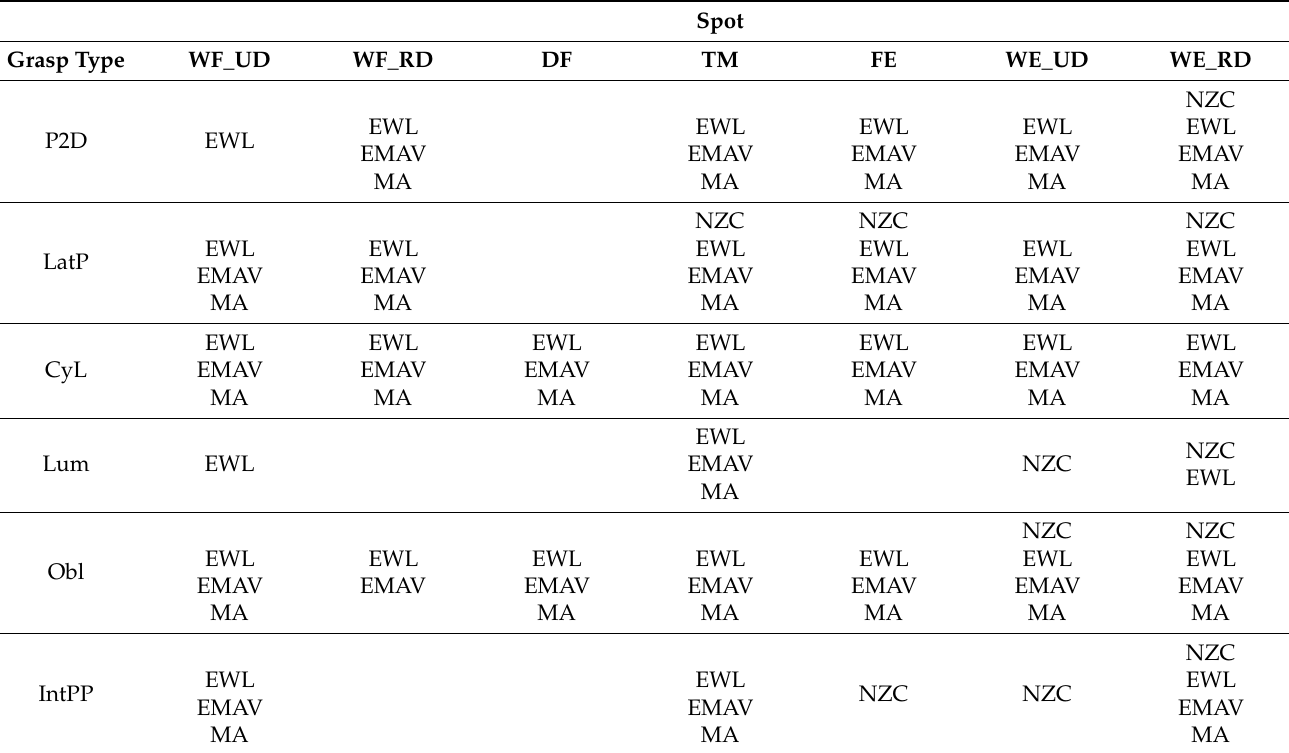
Table 4. Results of the MANOVA with the combined variable grasp x spot x EMG characteristic as input. Variables that significantly differ between H_w and HOA patients depend on the spot and grasp type. Abbreviations are defined in the Figure 5 caption.